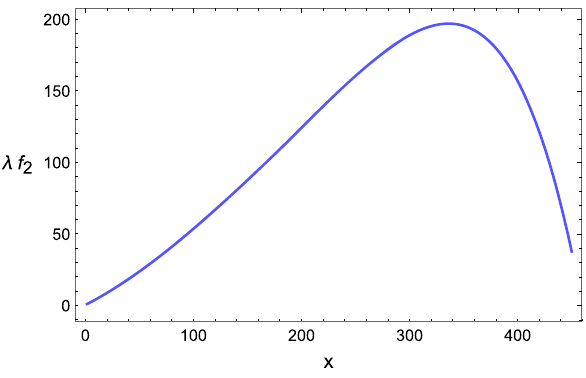
Fig. 1 A numerical solution of Eq. (31) for w = − 1 / 3 and λ = 10 − 5 . We have set the initial conditions as λ f 2 ( x = 1 . 5 ) = 1 and λ f (cid:5) 1 . 5 ) = 10 − 1 . The solution covers the range from the present till z = 8 . 92; i.e x = 450. The vertical axis is the coupling λ f 2 while the − horizontal axis is x = R κ 2 Λ